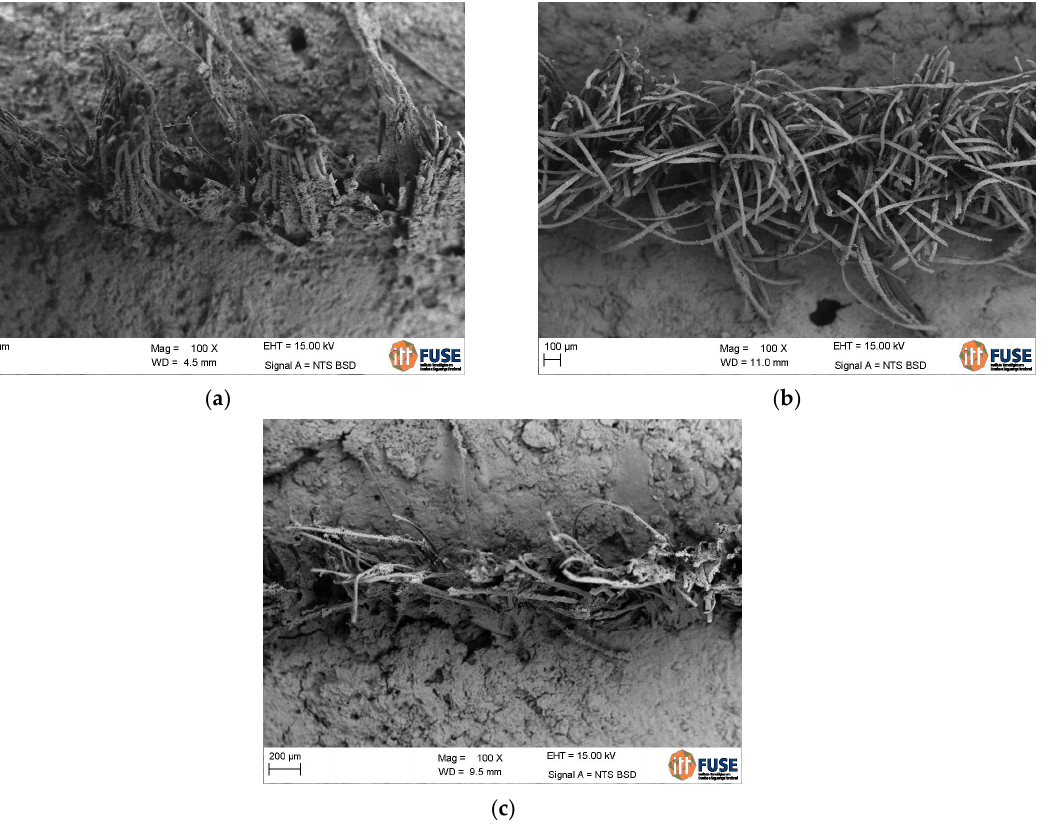
Figure 13. Microphotography of composites with textile reinforcement: ( a ) untreated, ( b ) SBR impregnated textile, and ( c ) SBR + SF impregnated textile.